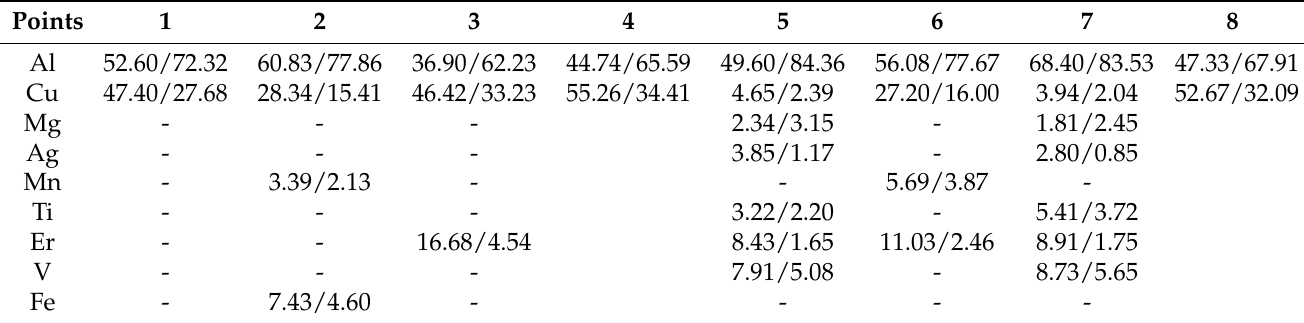
Figure 5. Backscattered electron (BSE) images of the as-cast alloys. ( a , d ) Er-free; ( b , e ) 0.09Er; ( c , f ) 0.20Er alloys. Table 2. EDS analysis (wt %/at %) of red points marked in Figure